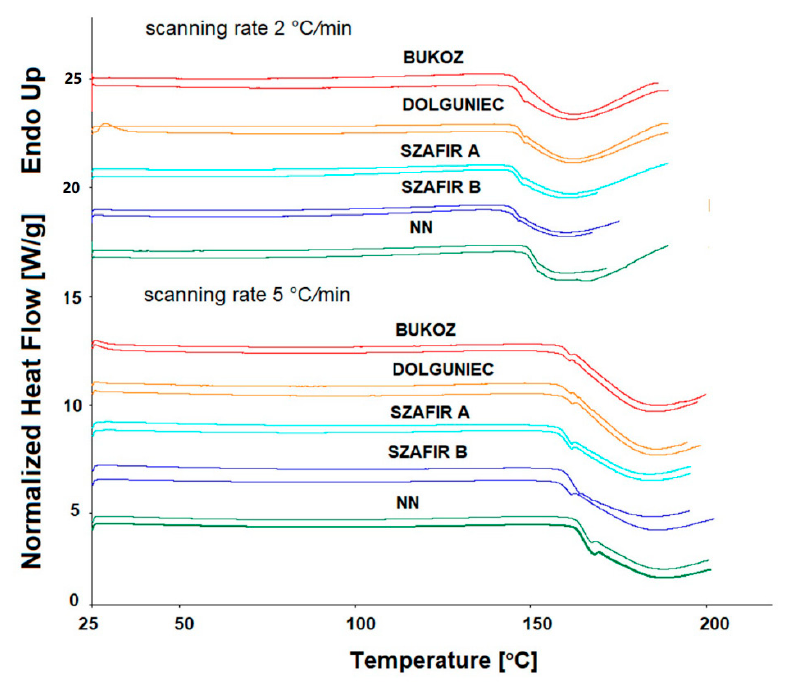
Figure 7. DSC non ‐ isothermal oxidation curves obtained at a scanning rate 2 and 5 °C/min for Figure 7. DSC non-isothermal oxidation curves obtained at a scanning rate 2 and 5 ◦ C/min for cold ‐ pressed flaxseed oils. cold-pressed flaxseed